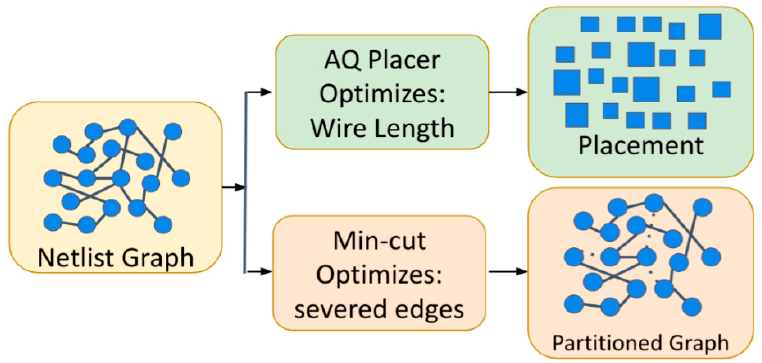
Figure 2. Comparison of the two implemented tier partitioning algorithms.